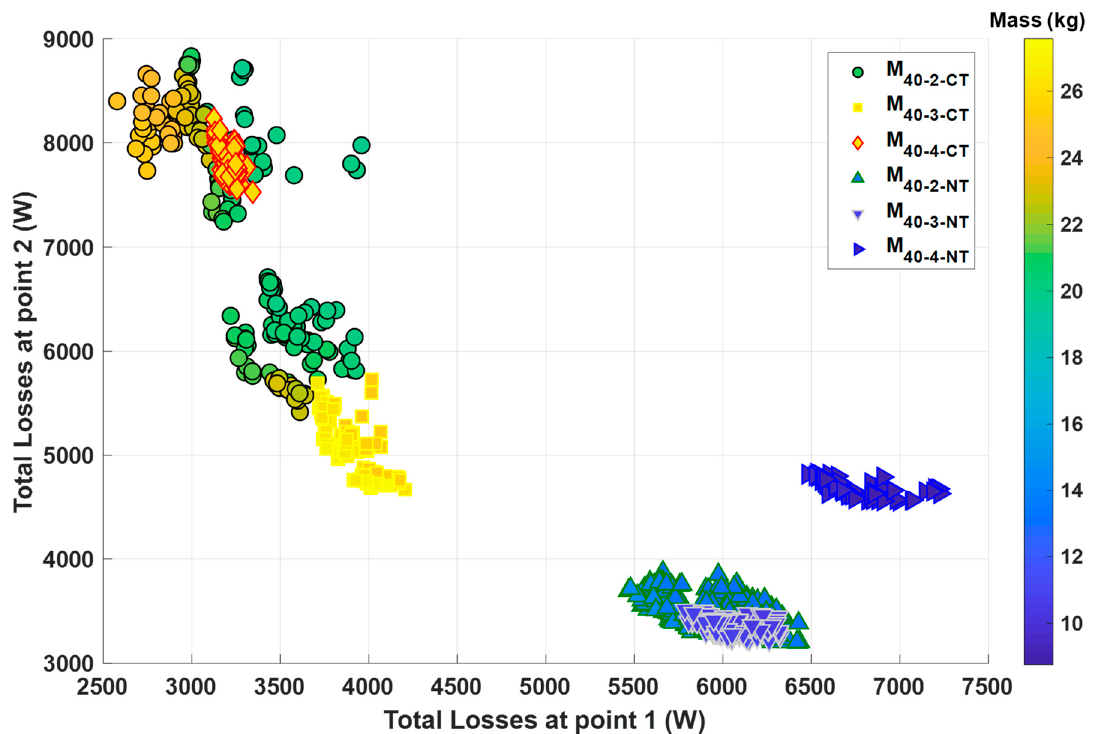
Figure 14. Pareto front of all electric machines operating at Ω (cid:3040)(cid:3028)(cid:3051) = 40,000 𝑟𝑝𝑚 .